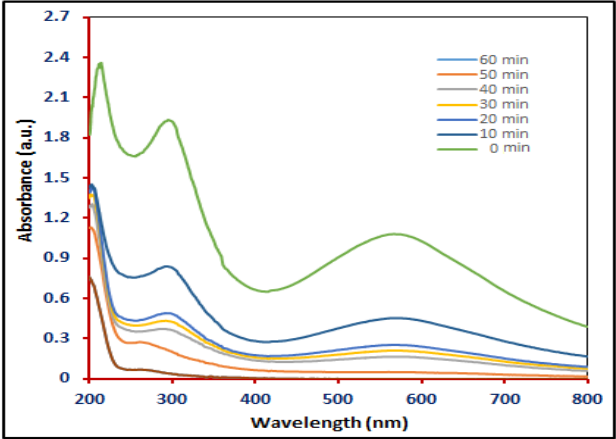
Fig. 8. Degradation of Nigrosine dye before and after exposure to visible light and photocatalyst with time.